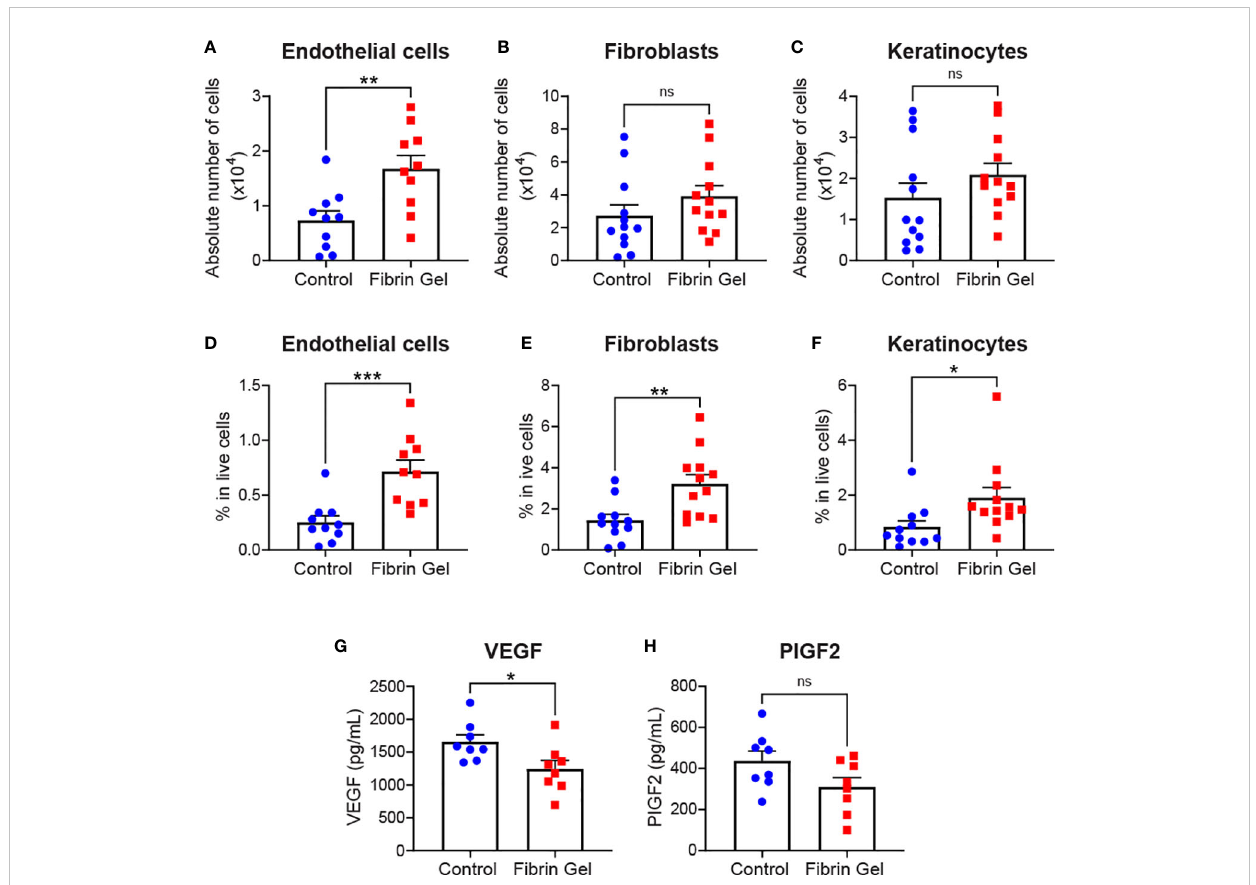
FIGURE 3 Effect of fi brin hydrogel on stromal cells, keratinocytes and endothelial growth factors in skin wounds. Cell populations and growth factors were analyzed 3 days postinjury in wounds treated with fi brin hydrogel (Fibrin Gel) and in wounds left untreated (Control). (A) Absolute numbers of endothelial cells (CD45 - , CD31 + ), (B) fi broblasts (CD45 - , CD31 - , CD140a + , CD90.2 + ) and (C) keratinocytes (CD45 - , CD31 - , CD140a - , CD49f + ). Percentages in total live cells were calculated for (D) endothelial cells, (E) fi broblasts and (F) keratinocytes. Concentrations of VEGF (G) and PIGF2 (H) were determined in wound homogenates by ELISA. *p<0.05, **p<0.01, ***p<0.001. Each symbol represents the data from a single mouse. Data are shown as mean ± SEM. ns, not signi fi